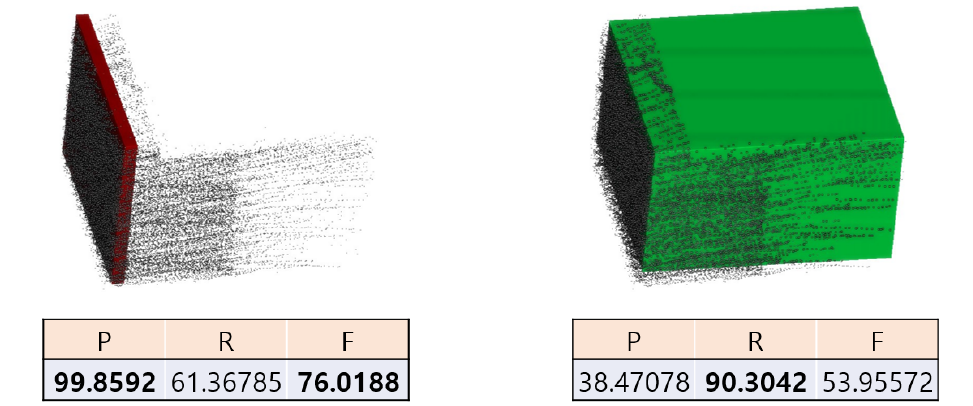
Figure 9. P, R, and F scores of the cuboid model obtained by Wei et al. [10] and proposed method. Although the results of Wei et al. [10], colored in red cuboid, do not cover most point clouds, higher scores are obtained in P and F metrics, and the proposed method yields higher score only in the R